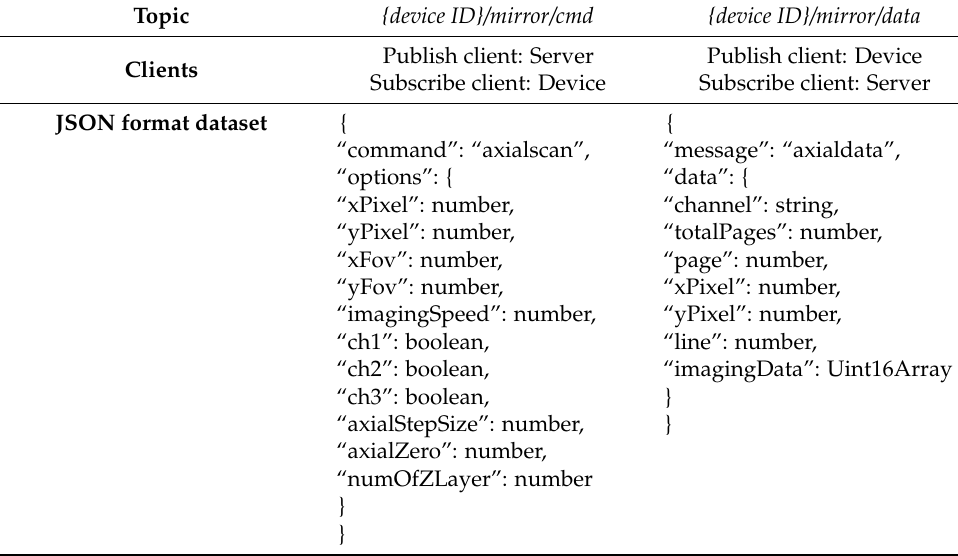
Table 1. Examples of a message set in JSON